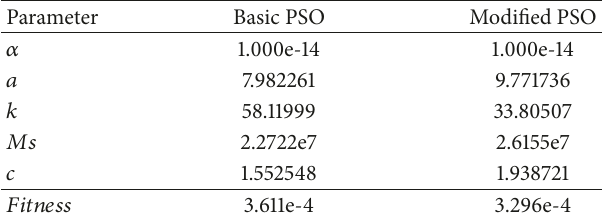
Table 2: Parameter identification results.